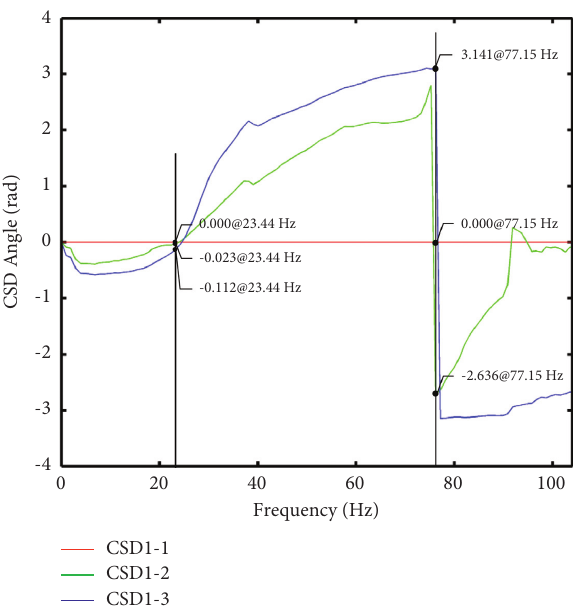
Figure 8: Phase angle curve of the power